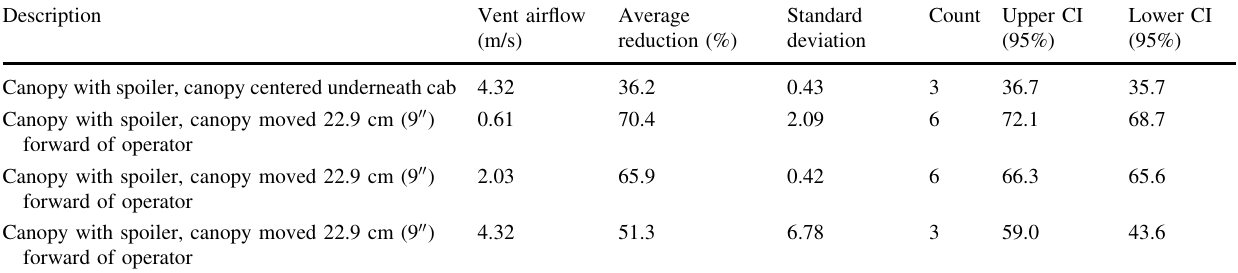
Table 4 Dust control reduction and associated statistics for a center-drive shuttle car at different ventilation airflows with different canopy configurations as shown in Figs. 8 and 9